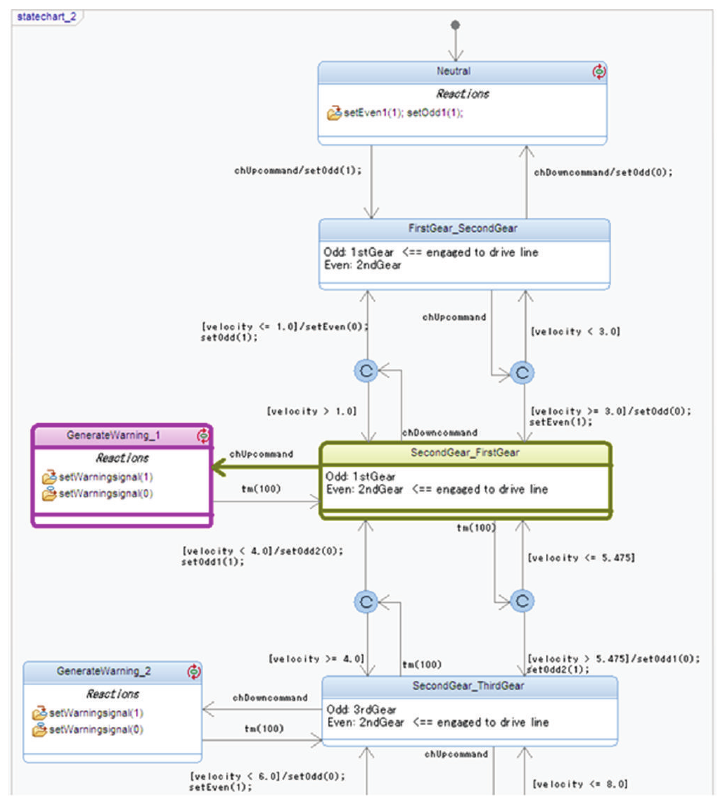
Figure 21: Animation of an S-Fucntion’s behavior.